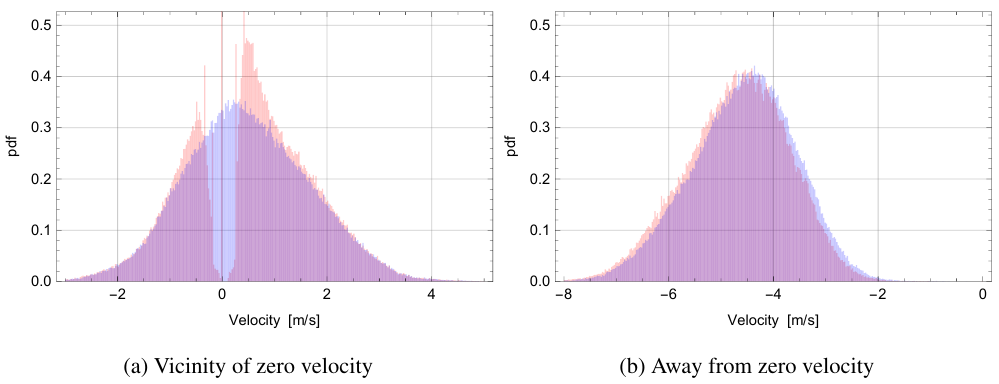
Figure 5. The PDF of estimated median velocities; in both figures, blue and red represent the measurements performed by the sonic anemome- ter and heterodyne CW CDL (HCDL), respectively. Please observe the gap in the PDF of velocities associated with the HCDL in (a) . The overshoots (when compared to the blue PDF) correspond to the accumulation of the estimated velocities associated with the frequencies away from zero as well as the inaccurately estimated velocities associated with the frequencies inside the gap.